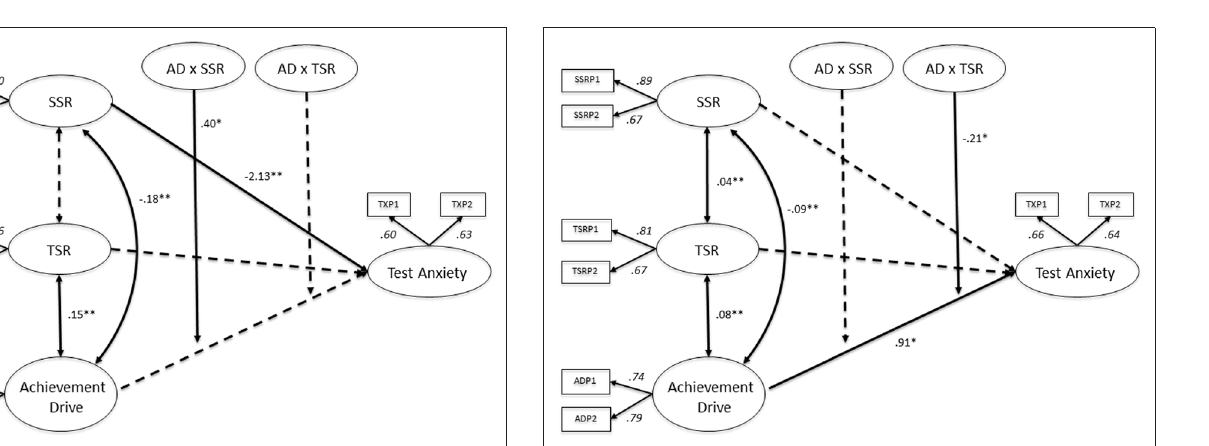
FIGURE 1 | Multigroup latent moderated structural equations (MGLMS) for the Canadian sample. Significant effects are shown as unstandardized coefficients (B), bold pathways are significant at * p < 0.05, ** p < 0.001; dotted pathways are not significant. Factor loadings are standardized (based on the standardized results of the weak measurement model seen as the final model only reports unstandardized results). TSR, teacher–student relationships; SSR, student–student relationships; AD, achievement drive.